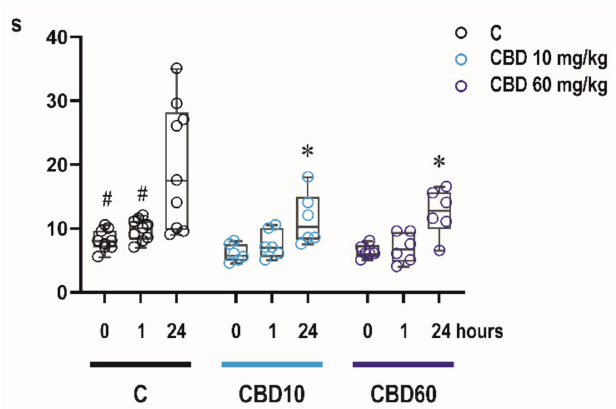
Figure 4. Effects of CBD on motor performance. Bar holding test—Time spent on bar. CBD did